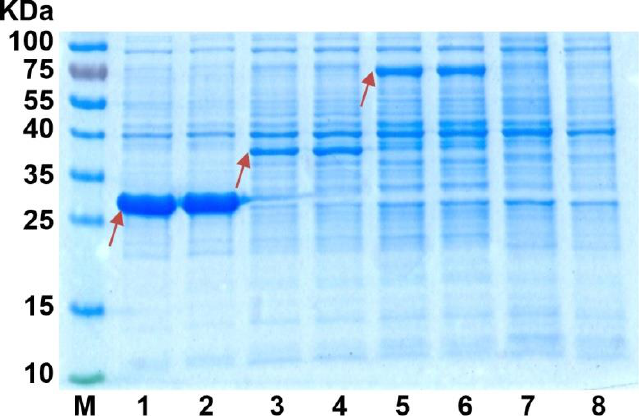
Figure 4. SDS-PAGE of proteins from crude extracts of E. coli BL21(DE3)/pET22b- DSD cells. Red arrows indicate the target protein. Lane: 1–2—AsbF, 3–4—Qa-4, 5–6—QsuB, 7–8—negative control without DSD. (Overall protein concentration was equal to 10 µ g in each